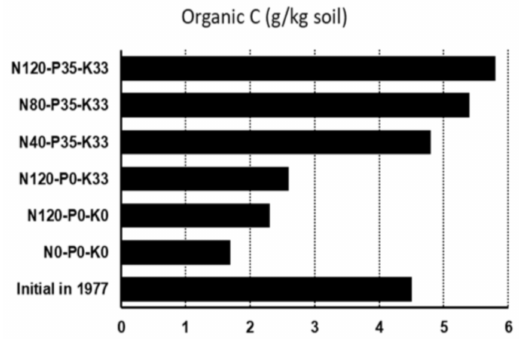
Figure 2. Effect of application of different combinations of N, P, and K fertilizers to rice–wheat cropping system for 20 years on organic C content in the soil in a long-term experiment at Faizabad, India. The numbers after N, P, and K indicate kg ha − 1 . Data source: Kumar and Yadav